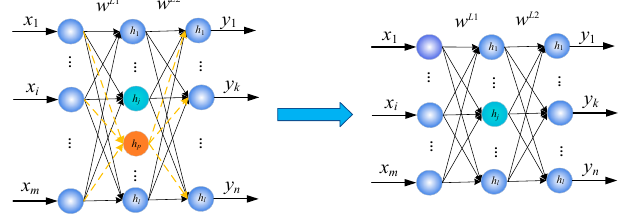
Figure 8. The pruning process of